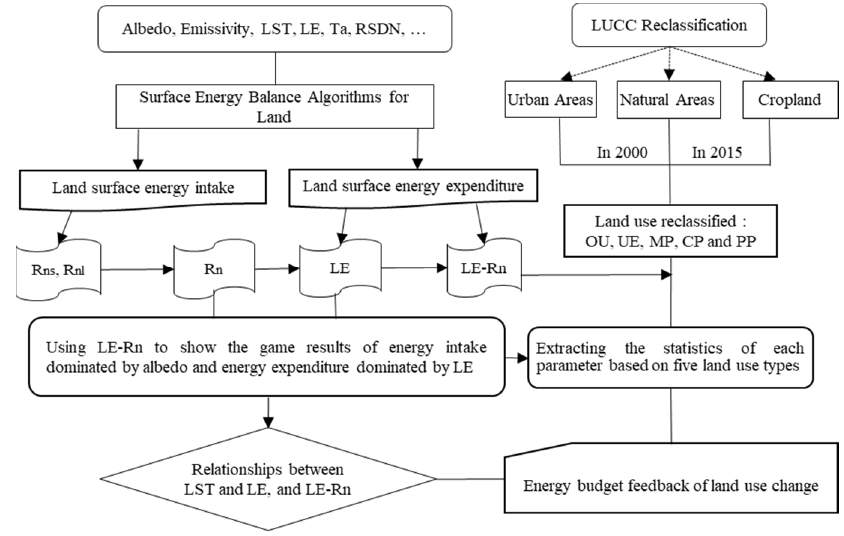
Figure 2. Basic research framework on energy budget feedback of land use change.